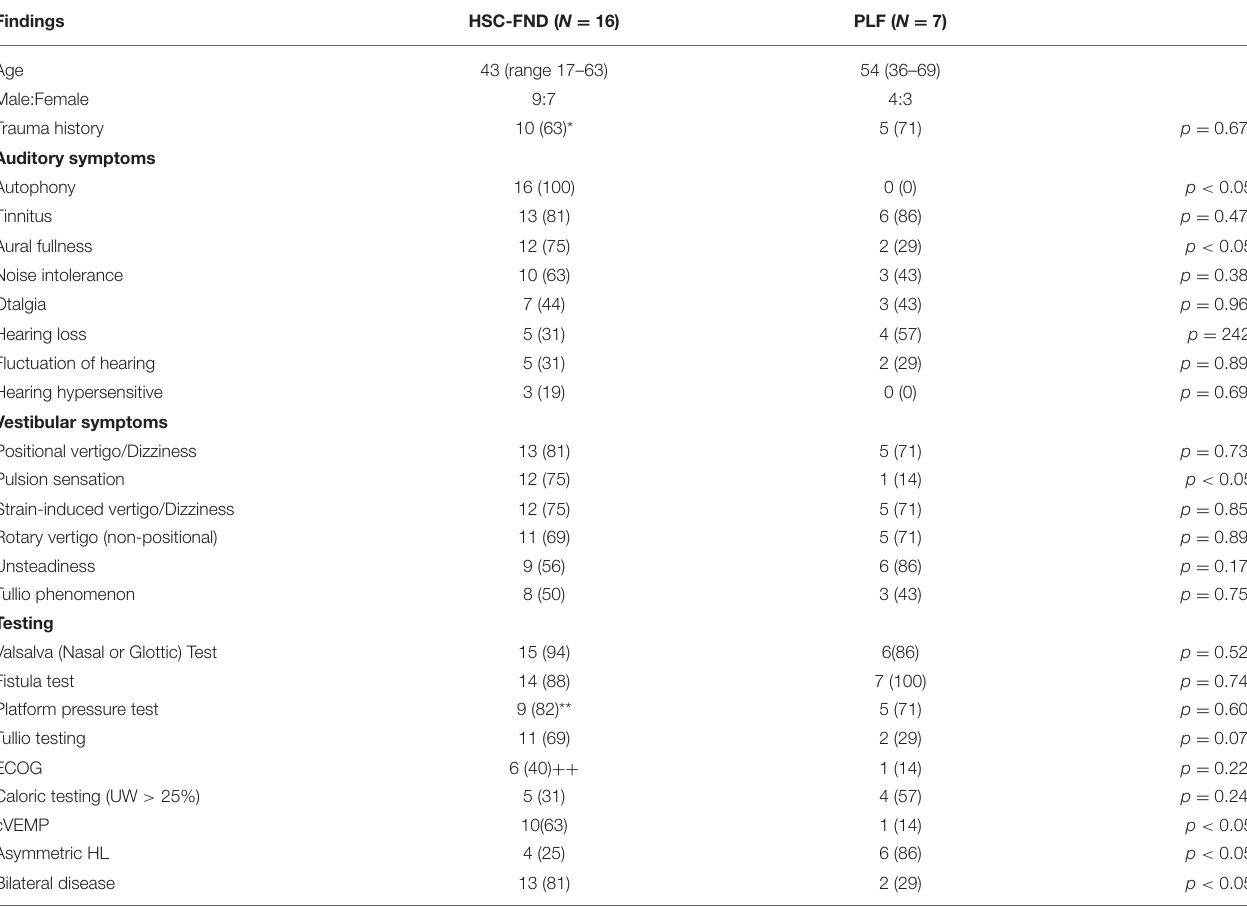
TABLE 1 | Auditory symptoms, vestibular symptoms and testing for HSC-FND patients ( N = 16) compared to PLF patients ( N = 7).